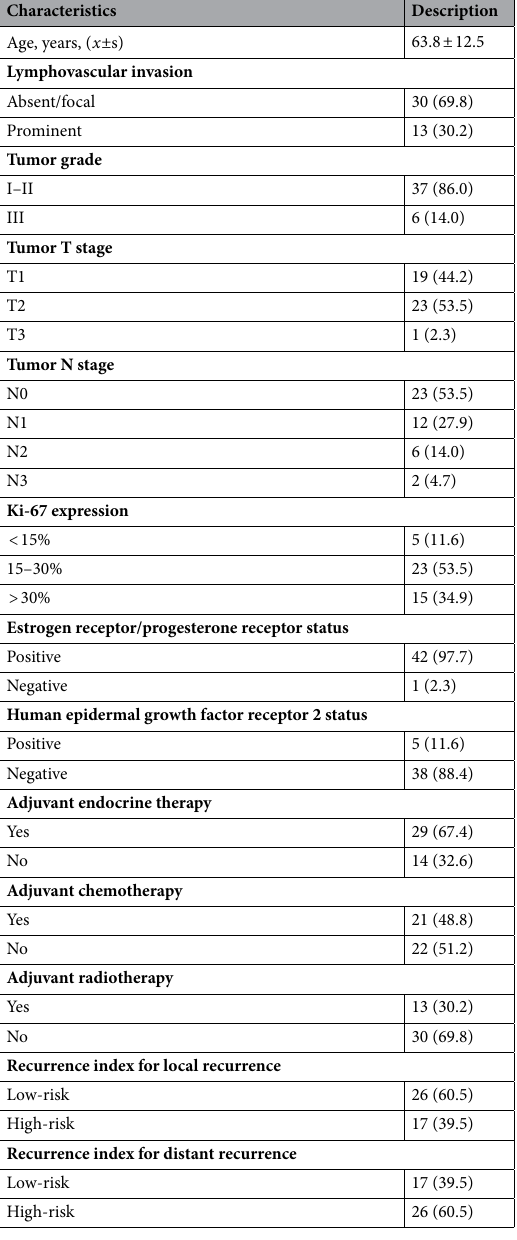
Table 1. Clinicopathological features of included patients, n